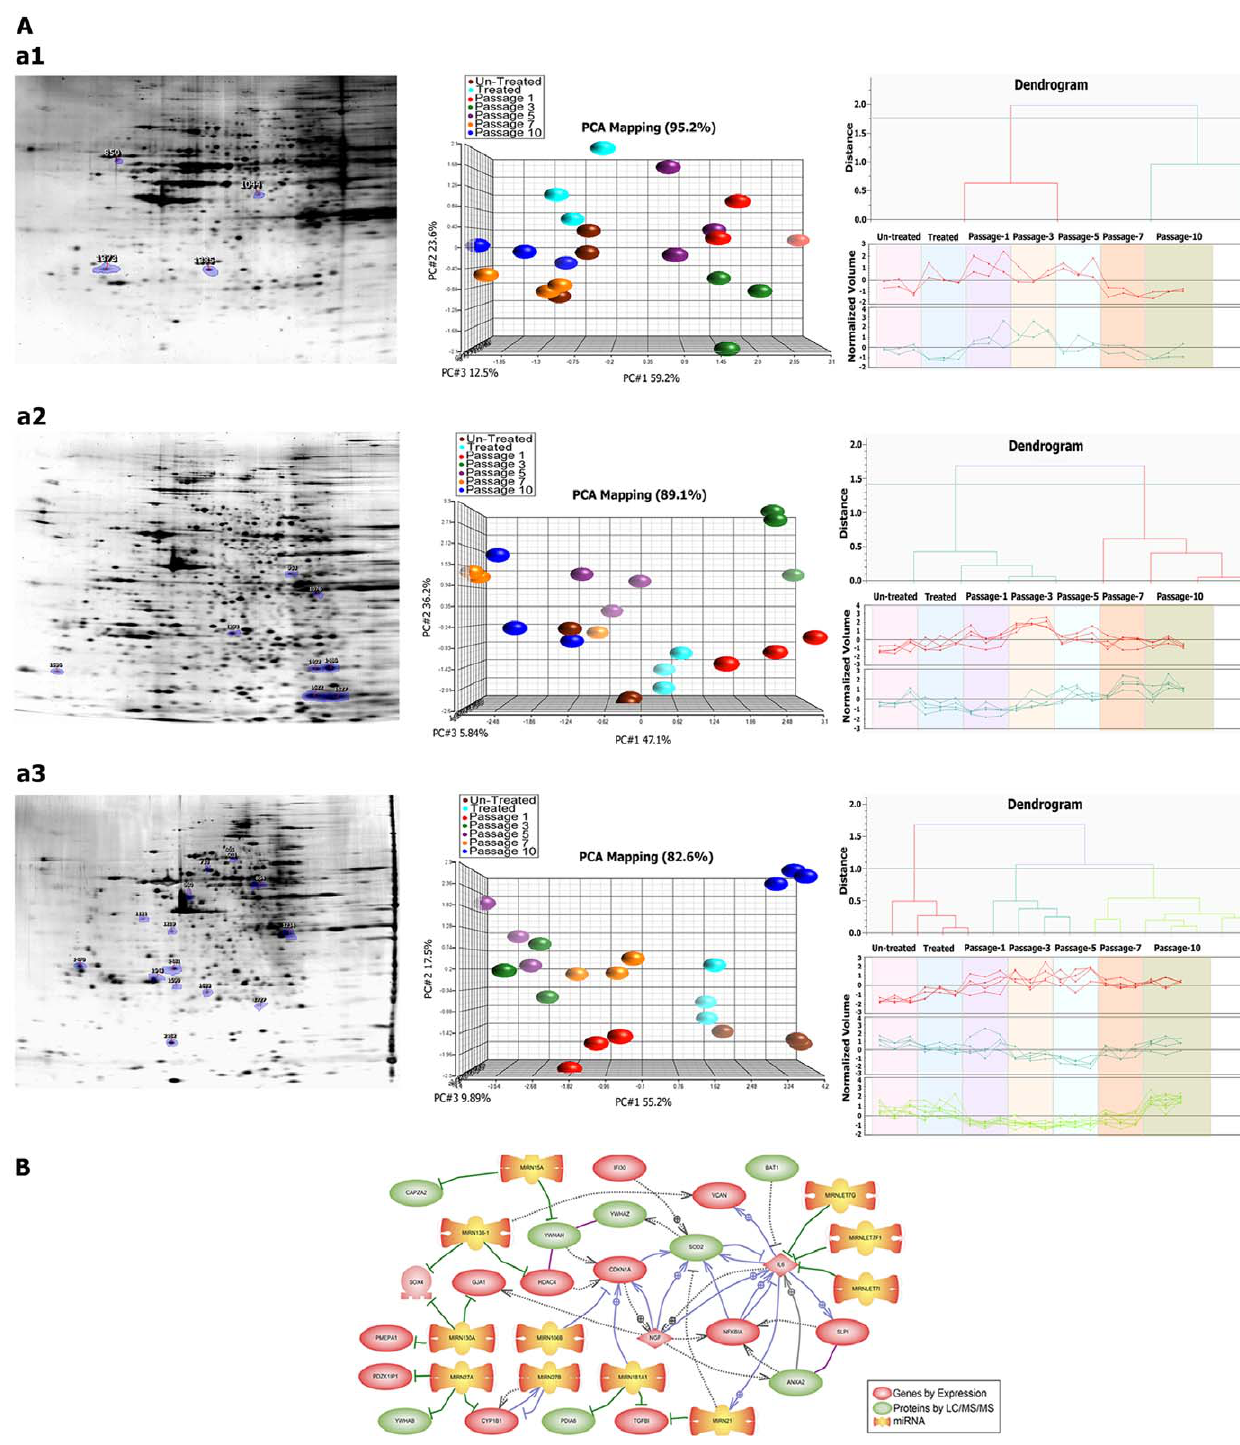
Figure 4. Protein expression matrix. A) Proteomics analysis of three cell lines. (a1 – a3 left panel) Proteomic images of representative gels of the three cell lines HB2, MDA-MB231 and SKBR3 with indicated spot positions excised for mass spectrometry analysis; spot picking performed from up/ down-regulated intersection proteins. (a1 – a3 middle panel) PCA analysis of intersection proteins from treated cells and follow up passages 1, 3, 5, 7 and 10 from three cell lines. (a1 – a3 right panel) Clustering and classification of significantly up/down-regulated proteins based on their profiles throughout the passages. B) Crosstalk between 3-dimensional Omics. Prediction of the possible interactions and links between intersection genes, miRNAs and proteins.